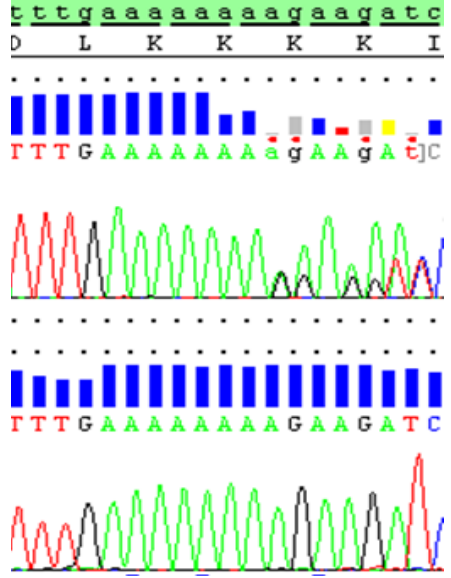
Figure 2. Chromatogram from Sanger DNA sequencing showing the novel c.419delA mutation in the MCEE gene in heterozygous form, as detected in the proband (top). The mutation causes a frameshift at Lys (K) 140 leading to a premature stop codon in the protein. Below is the normal reference sequence for comparison.